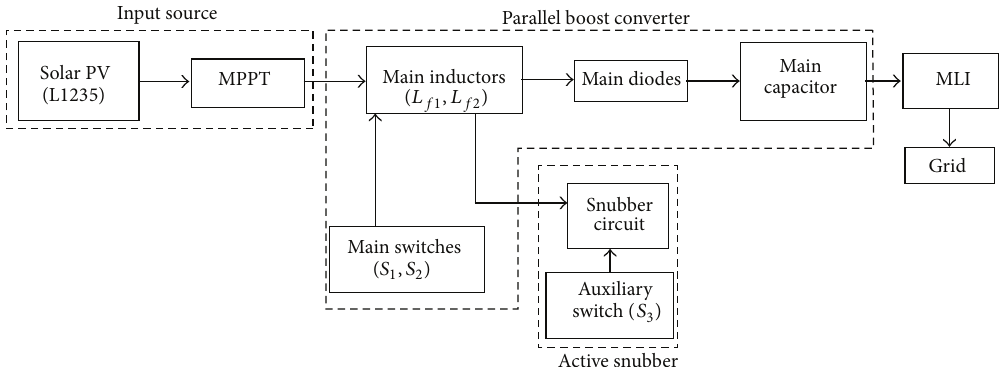
Figure 11: Block diagram of PV based parallel boost converter with active snubber.